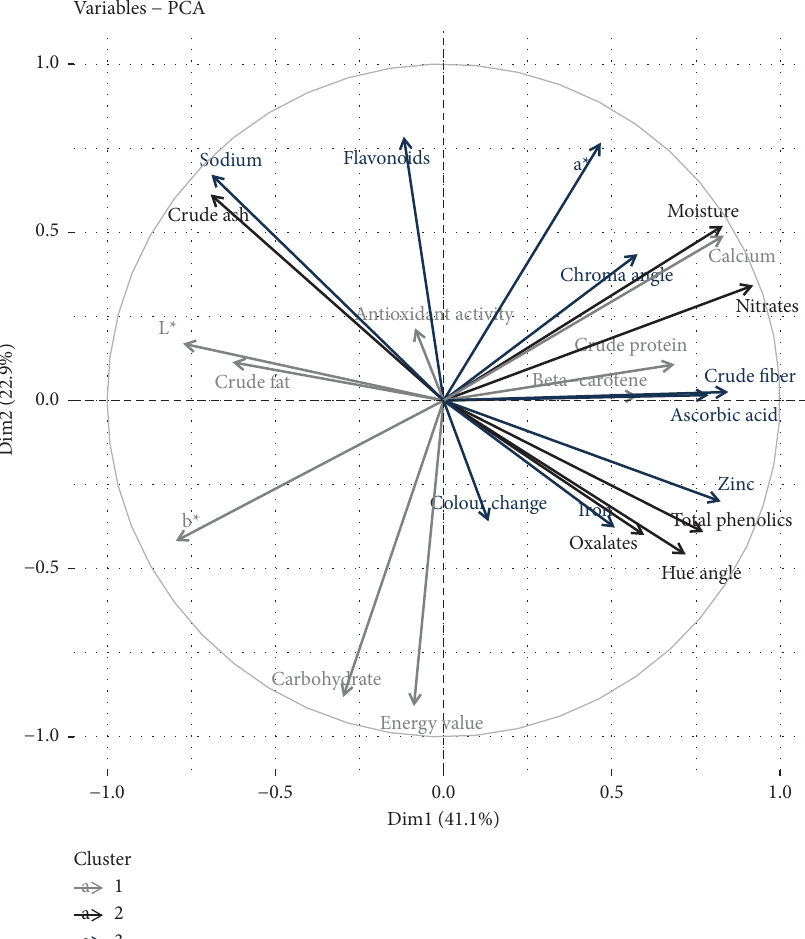
Figure 4: Correlation of plots showing clustering of the physicochemical attributes of optimally processed cowpea